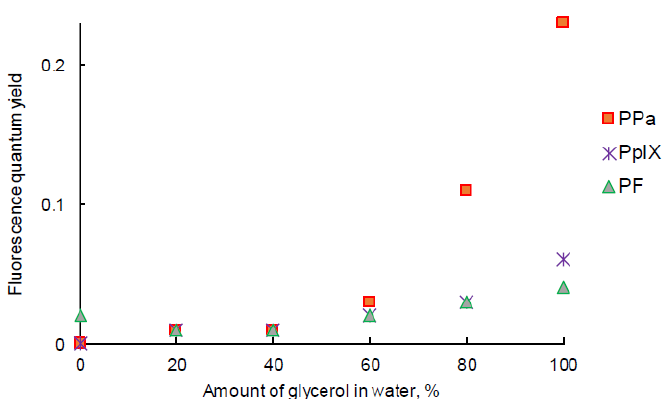
Figure 7. Fluorescence quantum yield of PpIX, PPa, and PF in the water/glycerol (W/G) mixture ( c = 3.1 µ M).